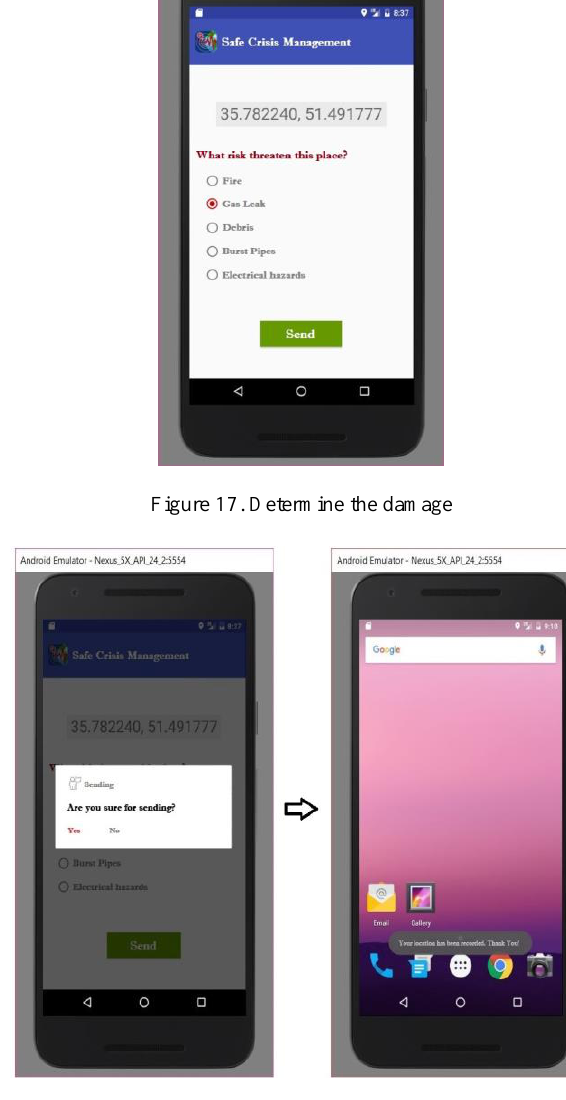
Figure 18. Verification of